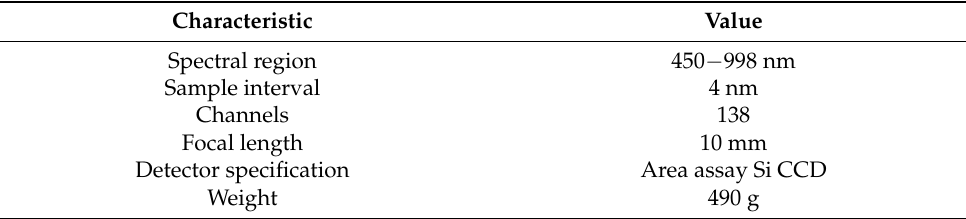
Table 1. Characterization of Cubert S185 device.